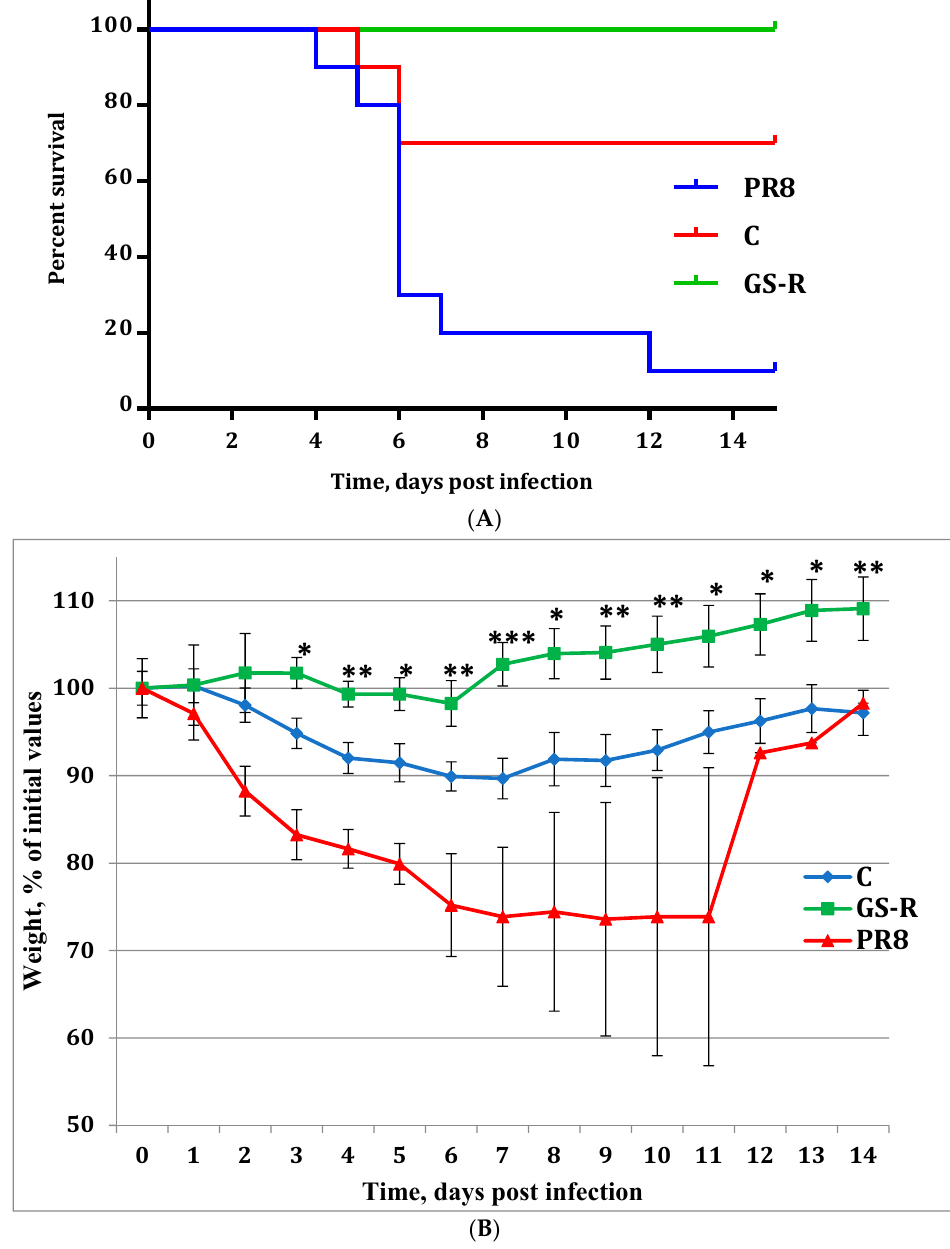
Figure 9. Effect of the development of GS-resistance on the pathogenicity of influenza virus A/Puerto Rico/8/34 (H1N1). Animals (ten per group) were intranasally infected with 5 × 10 4 TCID 50 per mouse of initial, egg-derived virus (PR8), virus after ten passages in MDCK cells (C), or virus after ten passages in MDCK cells in the presence of GS (GS-R). Animals were monitored daily for lethality and weight. ( A ) dynamics of mortality in the course of influenza pneumonia; ( B ) weight dynamics. Asterisks indicate the level of significance after comparison between C and GS-R viruses. * p < 0.05, ** p < 0.01, *** p < 0.001.